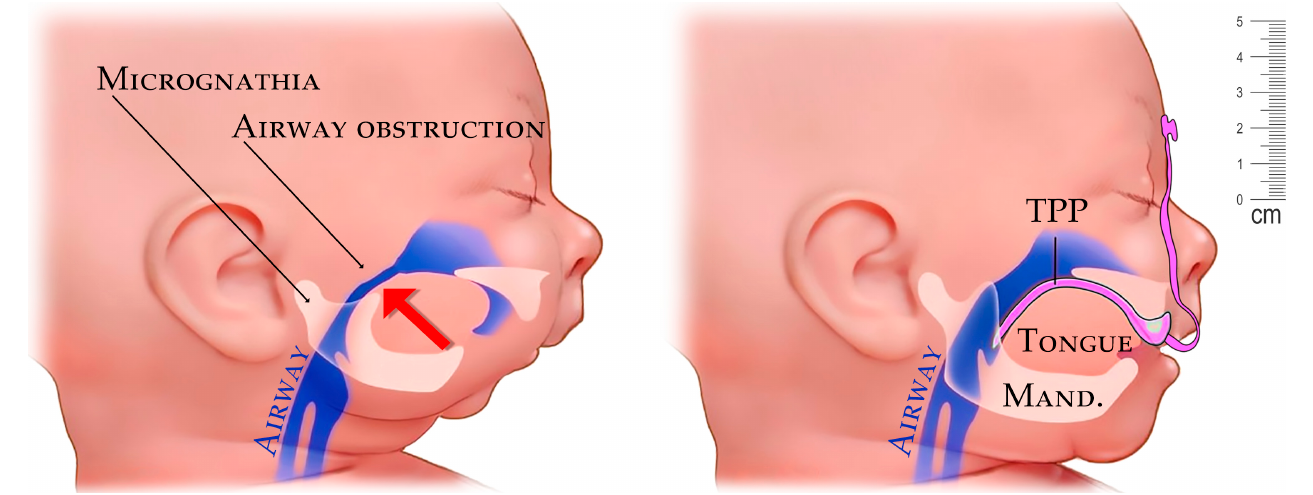
Figure 1. Example of airway stenosis (constriction) in a newborn caused from the pressure of the tongue from undersized mandible in micrognathia ( left ). Improvement of airway with placement of a personalized appliance—Tuebingen Palatal Plate (TPP) with extraoral part ( right ).